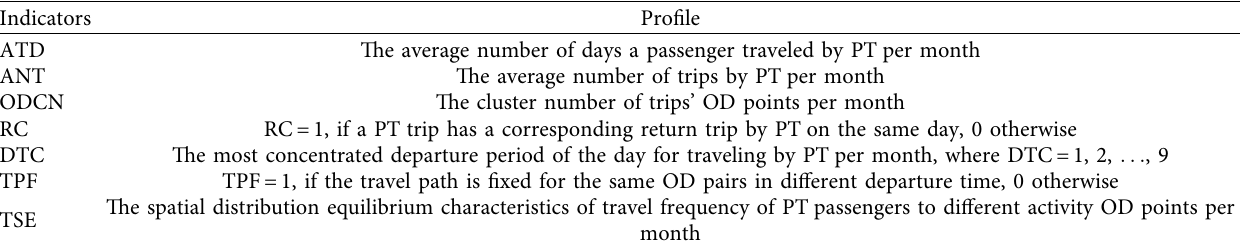
Table 3: Profile of characteristic indicators of PT commuter travel